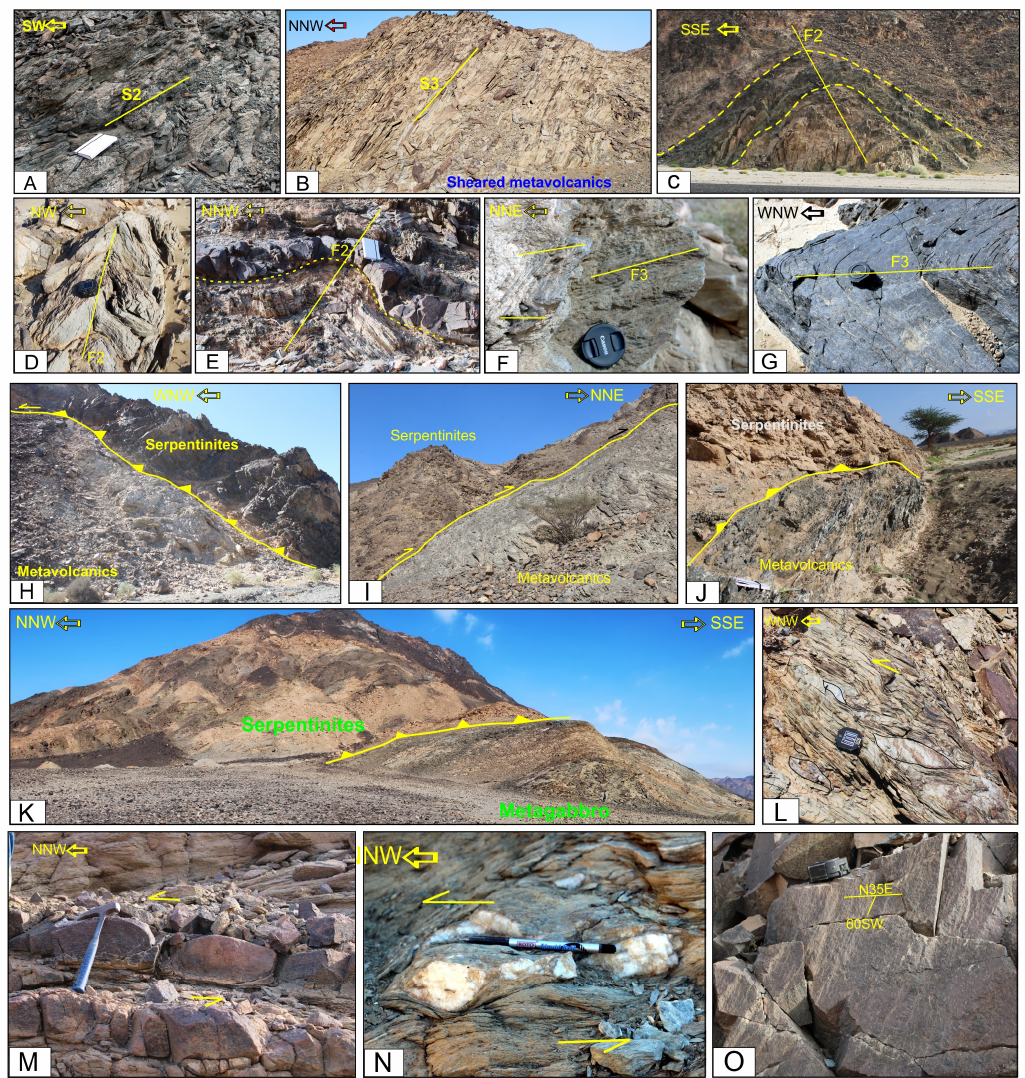
Figure 13. ( A ) S2 schistosity in highly deformed metagabbro along W. Baaneit east of G. Gerf, ( B ) Steeply dipping S3 foliation in sheared arc metavolcanics, northwest G. Gerf, ( C ) Upright open an- ticline F2 fold with core of serpentinite and limps of sheared arc metavolcanics, north G. Korabi, ( D ) Closure of the F2 fold in foliated arc metavolcanics with fold axis trending mainly NNW-SSE and plunging moderately 15°–35° toward NNW, south of G. Korab Kansi, ( E ) Closure of the open asym- metrical F2 anticline in highly sheared arc metavolcanics with a NNW-trending axis, to the west of G. Gerf, ( F ) Chevron F3 fold in arc metavolcanics at the entrance of W. Daqdib, ( G ) Symmetrical F3 anticlinal fold with a WNW- steeply plunging axis in the basic sheared arc metavolcanic to the northeast of G. Korab Kansi, ( H ) NNW-directed thrust between the serpentinite as hanging wall and sheared metavolcanics to the west of G. Korbiai, ( I , J ) W-directed thrust between the serpentinite as hanging wall and sheared carbonatized arc metavolcanics to the northeast of G. Korab Kansi, ( K ) W-directed thrust between serpentinites and metagabbros to the west of G. Madara, ( L ) A series of quar tz prophyroclasts in sheared carbonatized arc metavolcanics indicating top-to-W sense of movement along E-directed thrust, west of G. Gerf, ( M ) Boudinaged serpentinite signifying sinistral sense of movement, ( N ) Quar tz prophyroclast indicating sinistral sense of movement along NNW- trending strike-slip shear zone, ( O ) NE-striking normal fault with steeply dipping striae toward the northwest.